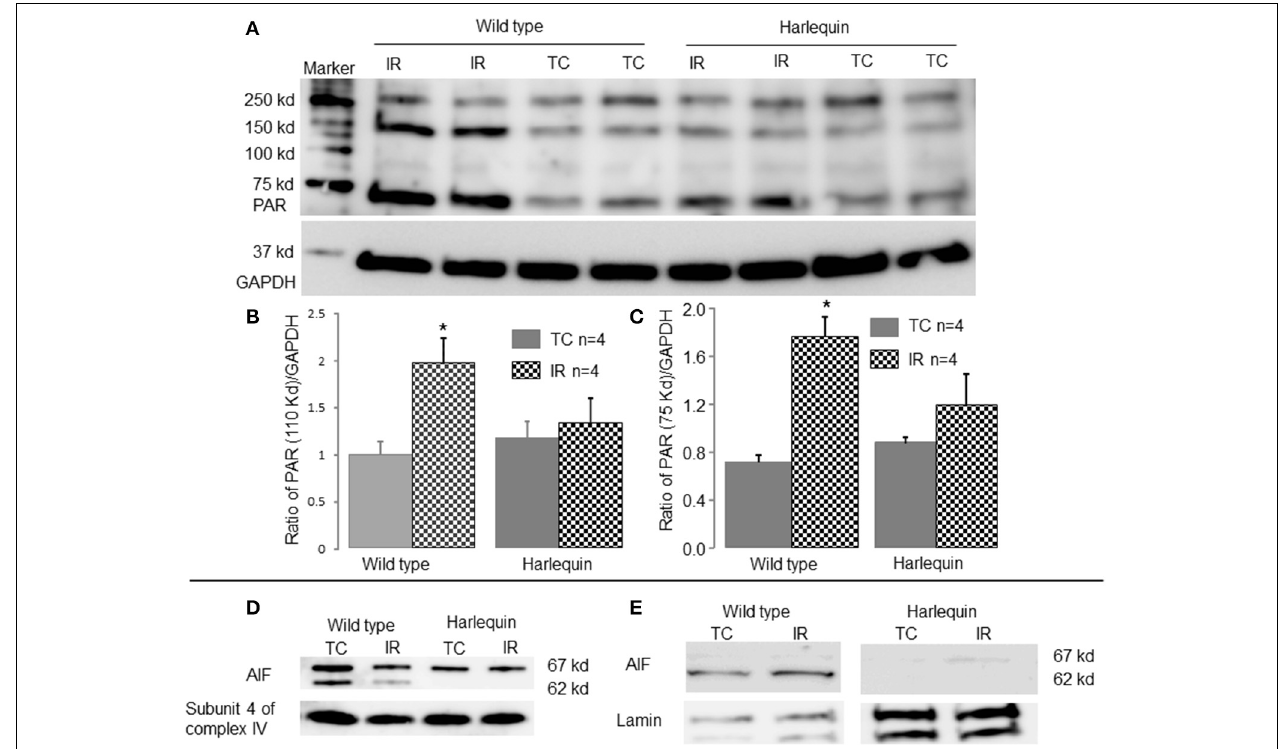
FIGURE 4 | IR increases AIF translocation from mitochondria to nucleus in wild type. The content of poly (ADP-ribose) (PAR) was markedly increased in wild type mice following IR compared to time control, indicating that IR activated PARP-1 (A–C) . There were no differences in the PAR content in Hq mice between time control and mice following IR (A–C) . GAPDH was used as a cytosol marker for loading control. The precursor form of AIF (67kd) and the mature form of AIF (62kd) were detected in wild type mouse heart